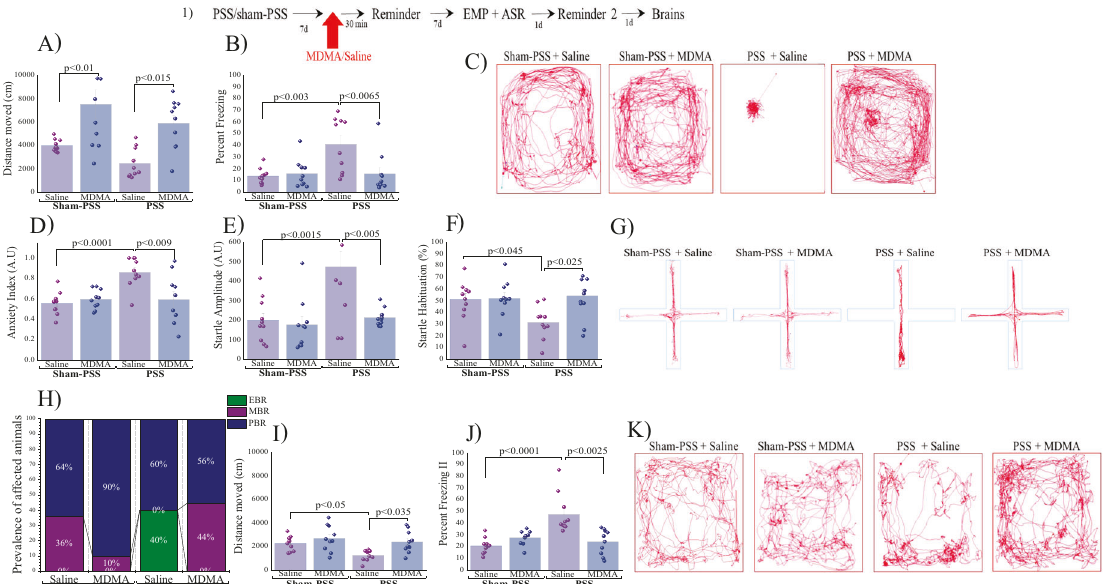
Fig. 1 MDMA treatment 30 min before trauma-cue at 7 days after trauma, attenuates behavioral stress responses The top panel (1) depicts the experimental protocol. Vertical arrows represent intraperitoneal MDMA (5 mg/kg) or saline injection. Rats were exposed for 10 min to predator-scent stress (PSS) or to sham-PSS on day 0. On day 7, rats received MDMA (sham-PSS + MDMA: n = 10; PSS-exposed + MDMA: n = 10) or saline (sham-PSS + saline: n = 11; PSS-exposed + saline: n = 10) and 30 min later were exposed to a trauma-cue for 10 min. During this time A LMA (distance moved; measured in cm); B Percent freezing response; C Representative patterns of locomotor activity (cumulated values) in all groups. Behavioral measurements (EPM and ASR) were performed on day 14 and freezing behavior on day 15. D Anxiety index, which integrates the measured EPM behavioral measures; E Startle amplitude in the ASR paradigm: F Percentage of startle habituation in the ASR paradigm. G Representative accumulated movement track during a trial. H Prevalence of extreme behavioral response (EBR) vs. partial behavioral response (PBR) and minimal behavioral response (MBR) rats (in percentages). Signi fi cant differences were found between groups in the prevalence rates of individuals displaying an extreme, minimal, and partial behavioral response (Pearson χ 2 = 18.85, df = 10, p < 0.0045). Finally, effect of trauma-cue at day 15 on LMA I (distance moved; measured in cm); and J Percent freezing response. K Representative patterns of locomotor activity (cumulated values) in all groups. The experiments described below were performed with two different cohorts of animals; 20 rats were run in one experimental design (5 rats/each group), and 21 rats in another experimental design (5 – 6 rats/each group). Bars represent group means ± SEM and